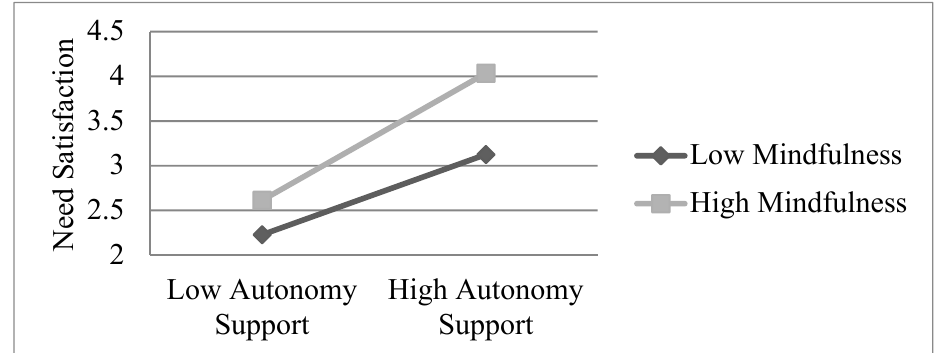
Figure 1. Moderation e ff ect of mindfulness on the relationship between autonomy support and need satisfaction.